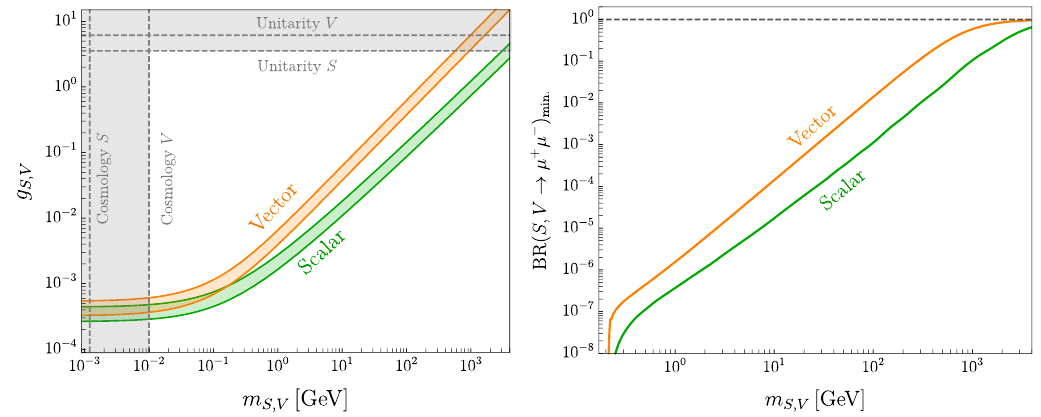
Figure 2 . Left: parameter space for which one SM singlet scalar or vector particle resolves the ( g − 2) anomaly. The thickness of each band represents the ± 2 σ confidence interval and the vertical µ axis is the corresponding muon-singlet coupling from eq. (1.4). The vertical shaded region represents the bound on light relativistic species present in equilibrium during big bang nucleosynthesis. The horizontal shaded region is the bound from partial wave unitarity. For a discussion of these bounds, see section 2.3. Right: minimum di-muon branching fraction for vector and scalar couplings that resolve the ( g − 2) anomaly, from eqs. (2.5) and µ